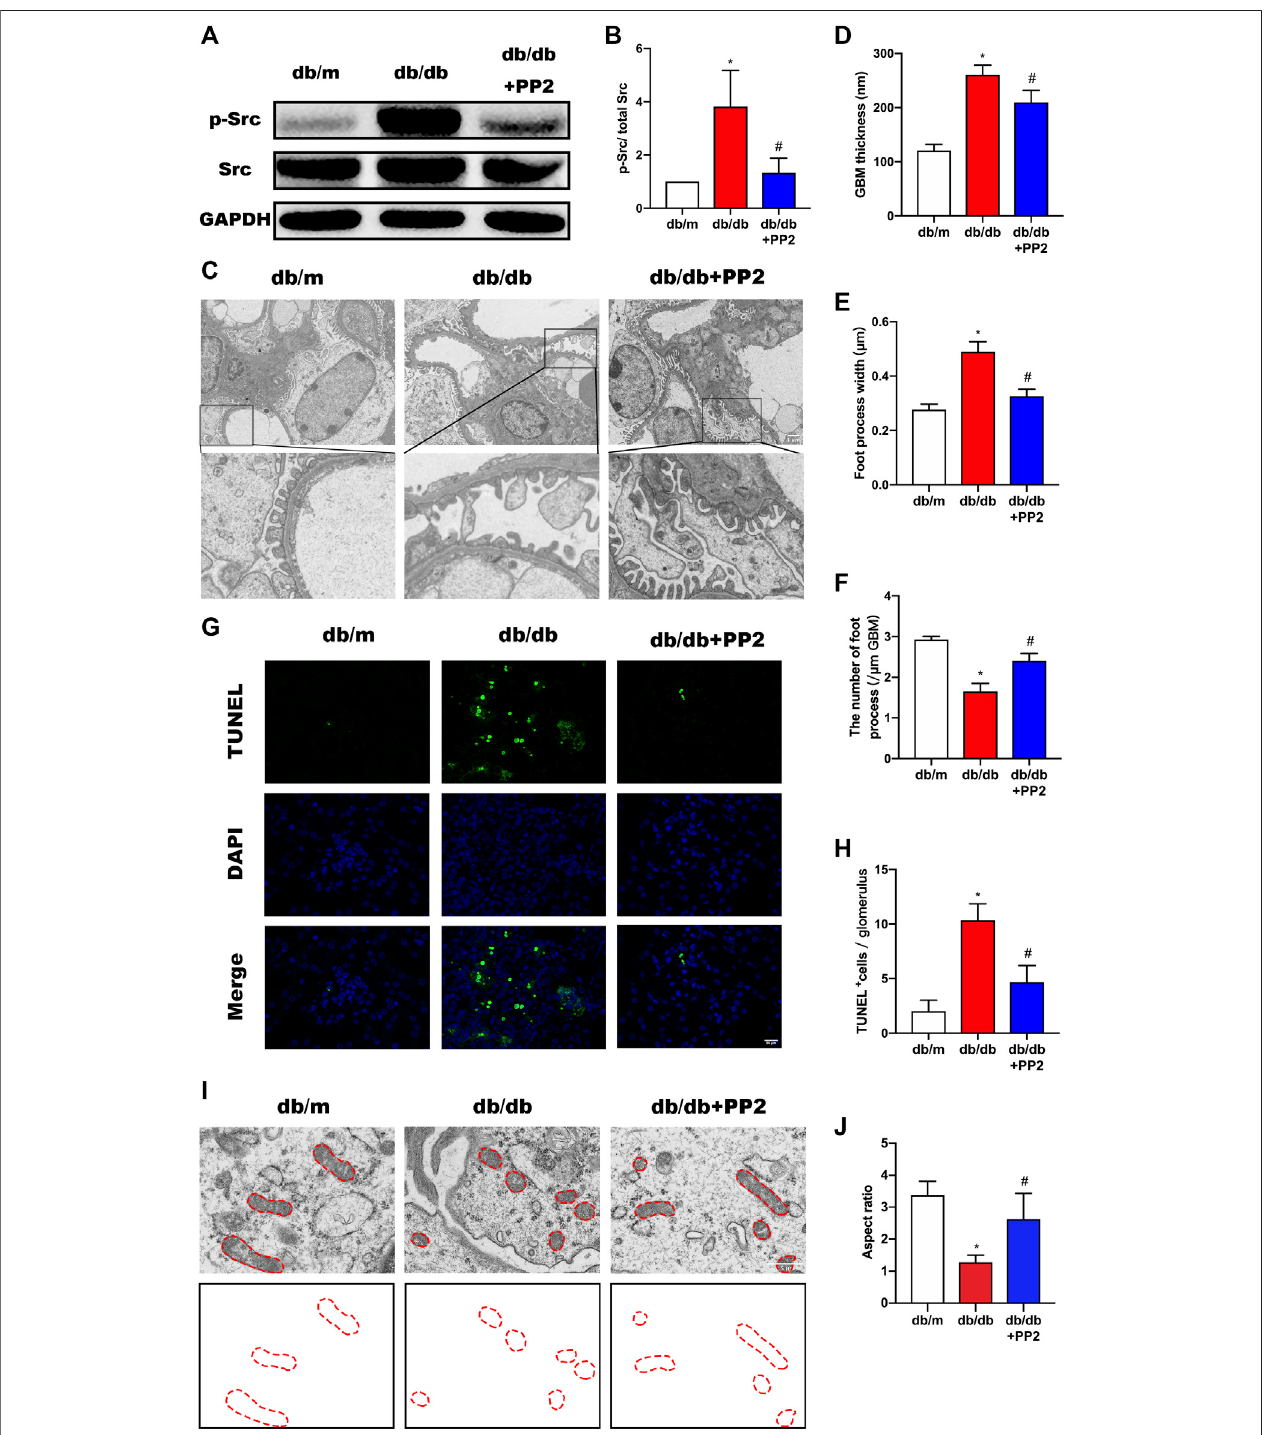
FIGURE2| InhibitionofSrcactivity amelioratespodocyte injury. (A) RepresentativeWesternblotimages ofSrc andp-Src levels inkidney tissues fromthedifferent treatment groups. (B) Quanti fi cation of expression levels of Src and p-Src; GAPDH was used as the loading control. (C) Representative transmission electron micrographsshowingchangesinpodocyteinthekidneysofthedifferentgroups.(Magni fi cation,3000×). (D – F) Quantitationofthethicknessoftheglomerularbasement membrane (GBM), foot process widths and number of foot processes/µm. (G) TUNEL assays evaluating cell apoptosis in glomeruli among the different groups. TUNEL-positive (apoptotic) cells are stained green, and nuclei labeled with DAPI (blue). (Magni fi cation, 400 ×). (H) Quantitative calculation of number of TUNEL-positive cells in each glomerulus. (I) Representative electron micrographs of mitochondrial ultrastructure in podocytes from each treatment group. (Magni fi cation, 12,000 ×), (J) Quantitative calculation mitochondrial aspect ratio in each group. Values are expressed as the mean ± SD, * p < 0.05 vs. db/m group; # p < 0.05 vs. db/db group. n = 5.